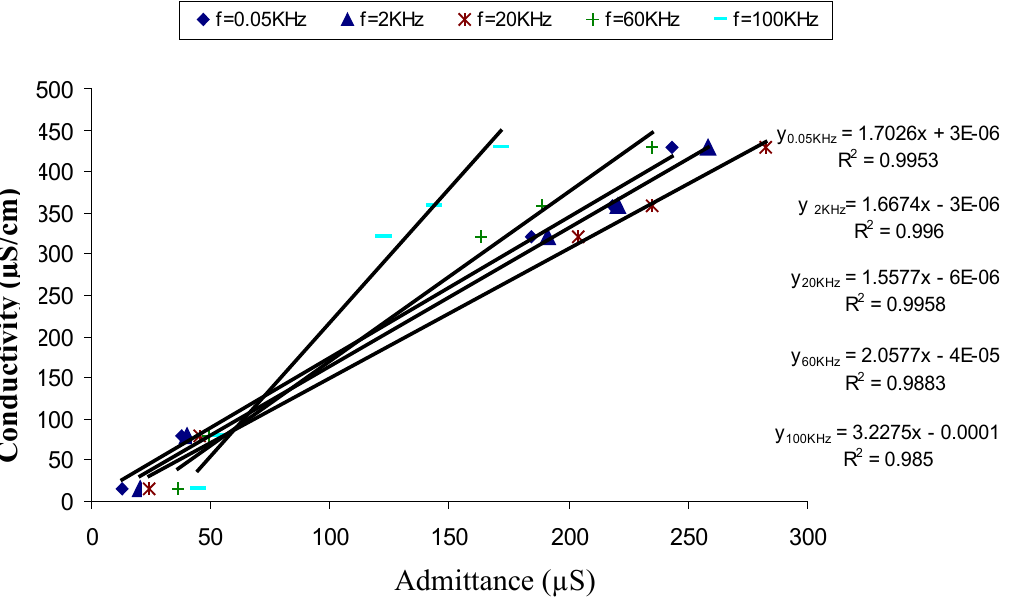
Figure (2): The relationship between admittance and conductivity is linear at frequencies (0.05, 2, 20, 60 and 100 kHz) for the 4-electrode